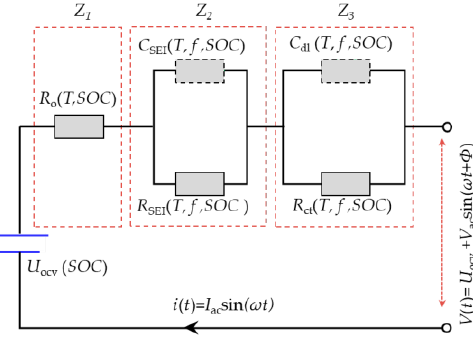
Figure 1. Equivalent electrical circuit (EEC) model.